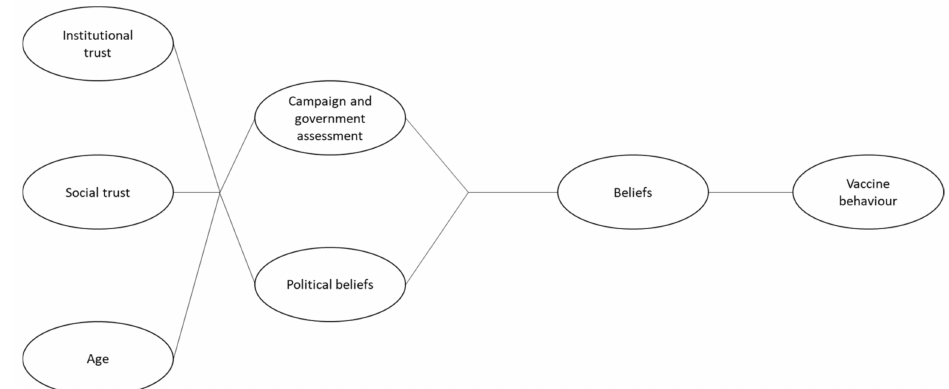
Figure 1. Conceptual model.